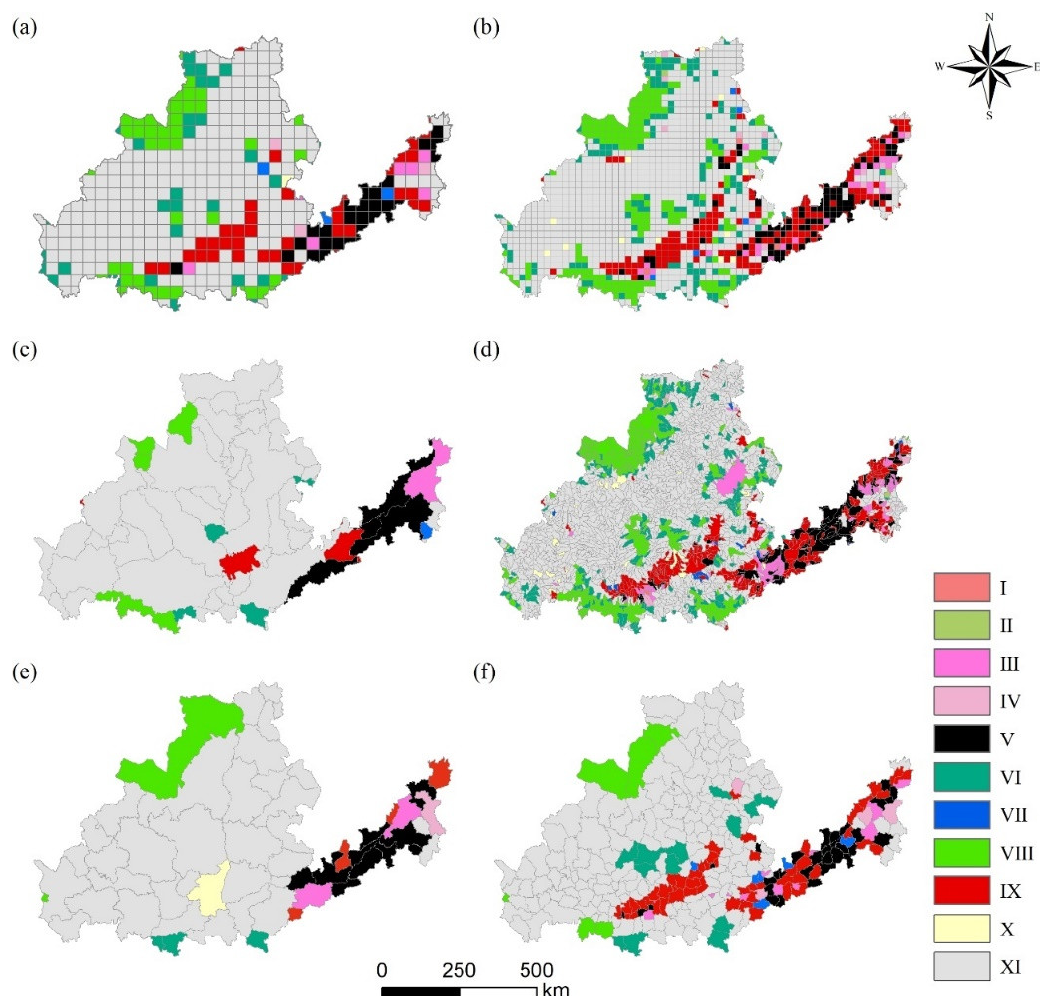
Figure 8. Optimization of production-living-ecological space on multiple scales (( a ). the 40 × 40 km grid scale; ( b ). the 20 × 20 km grid scale; ( c ). the primary catchment scale; ( d ). the secondary catchment scale; ( e ). the city scale; ( f ). the county scale. TheIto XI corresponds to Figure 7